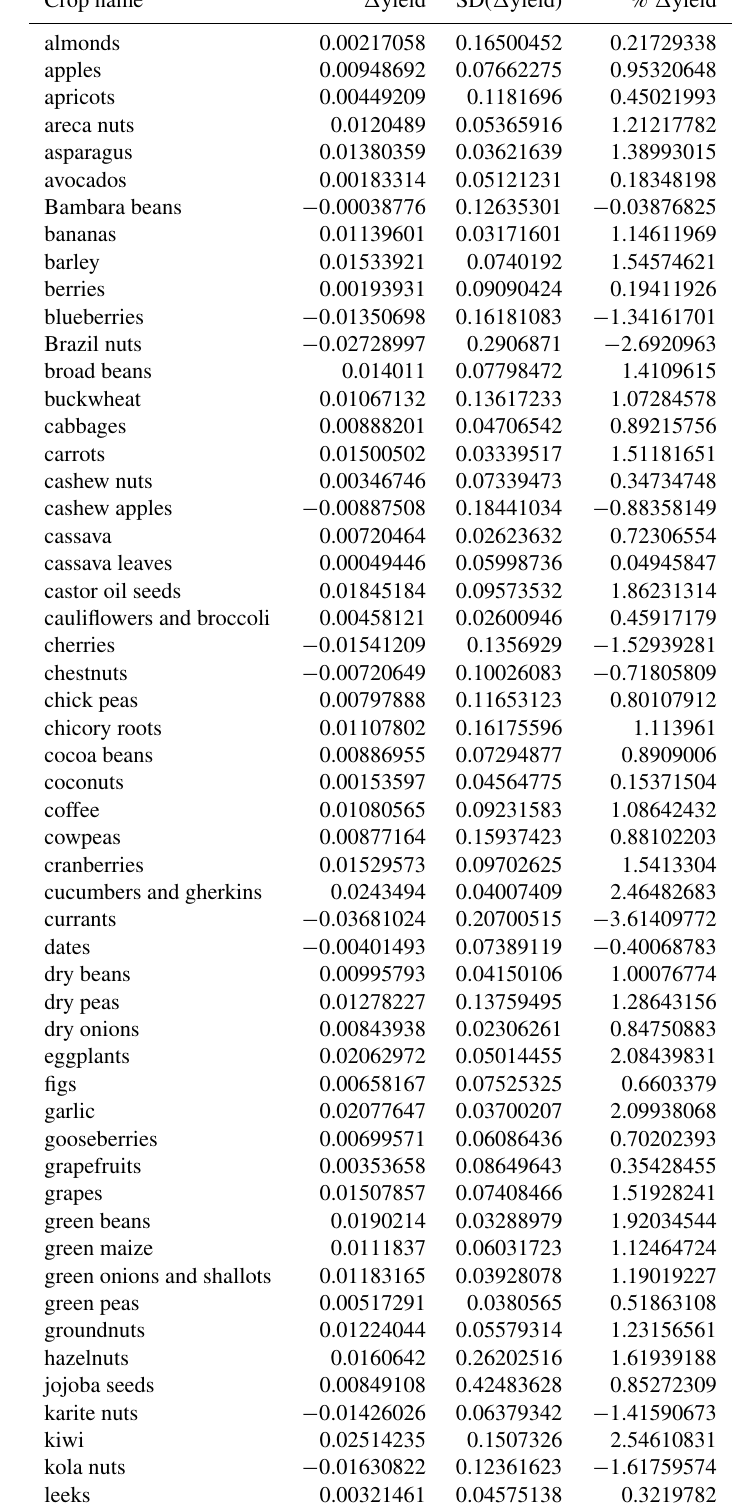
Table A3. Mean yield growth ( (cid:49) yield), interannual yield variation (SD( (cid:49) yield)), and mean annual percent increase in yield (% (cid:49) yield) for the FAO crops/items included in the study. Data were obtained from the FAOSTAT database and covered a 57-year period (from 1961 to 2017) for all but three crops (see Methods for